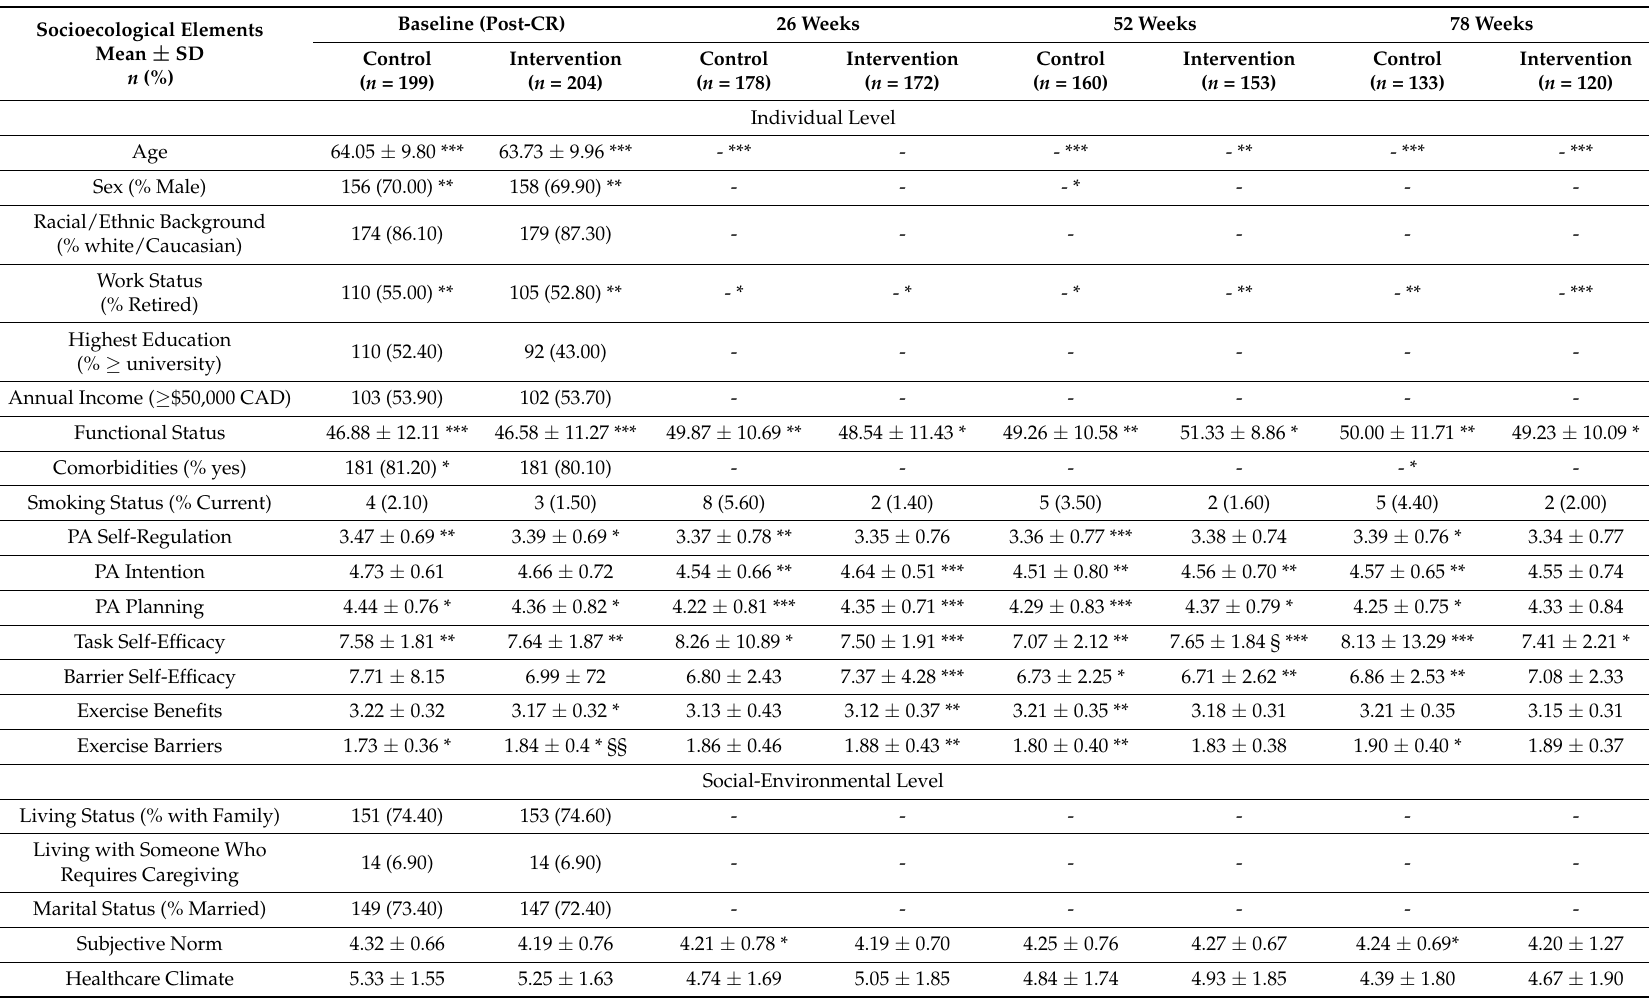
Table 1. Socioecological Elements, by Level and Study Arm through 1.5 Years Following Cardiac Rehabilitation Completion and Association with Moderate and Vigorous Intensity Physical